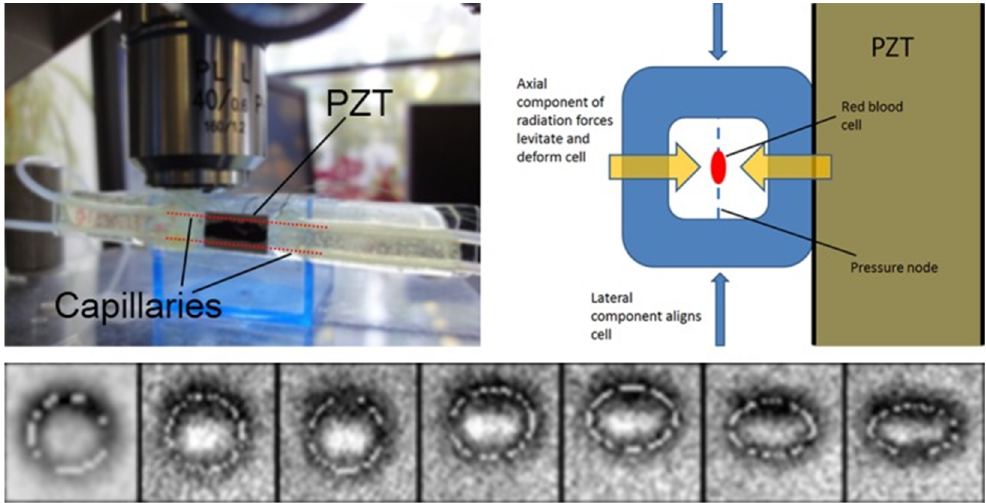
Figure 8. Acoustic trapping of single cells in a square cross-section glass capillary ( 𝑎 = 0.1 mm). Single red blood cells were trapped at the center of the fluid channel by a half-wavelength standing wave field. With the increase of acoustic pressure amplitude, deformation of a red blood cell was increased towards an ellipsoid. Reprinted with permission from [59] .